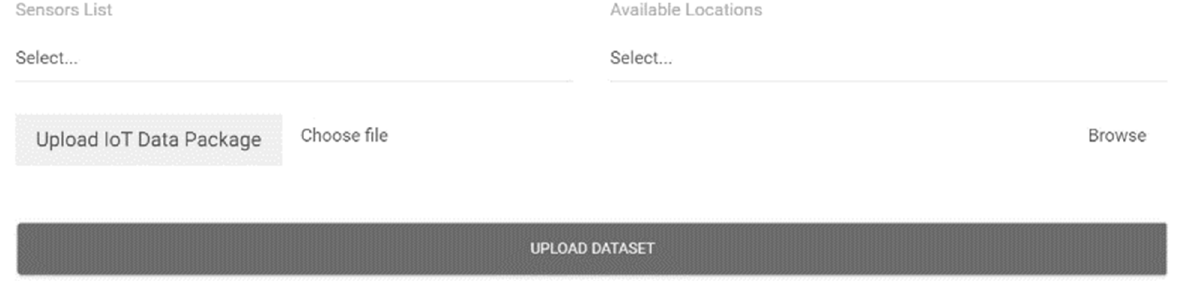
Figure 6. Case Study Trail Performed.